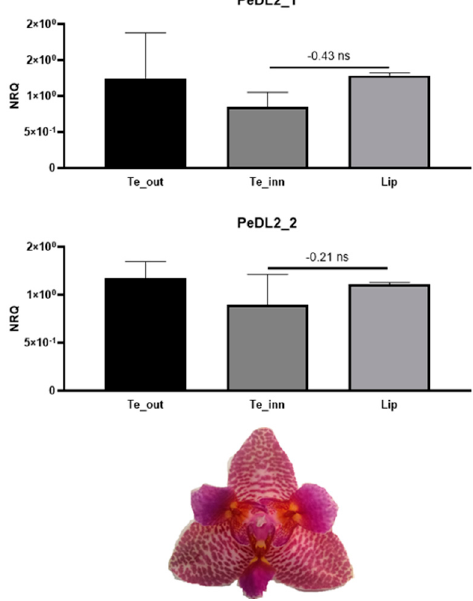
Figure 6. Relative expression of the isoforms PeDL2_1 and PeDL2_2 in the perianth of the peloric Phalaenopsis hyb. “Joy Fairy Tale” at the B2 developmental stage (bud size 1–1.5 cm). The expression is reported as normalized relative quantity (NRQ). The vertical bars represent the SEMs of the biological and technical replicates. The numbers above the horizontal lines are the mean differences of the expression between labellum-like structures and labellum (Te_inn-Lip). ns, not significant. Te_out, outer tepals; Te_inn, labellum-like structures that substitute the lateral inner tepals in the peloric mutant.